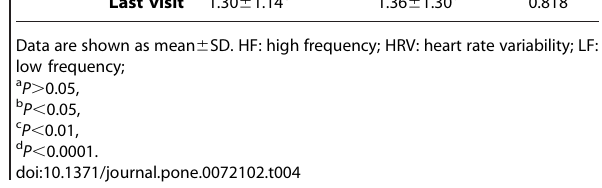
Figure 3. Changes in RHR from baseline to the end of treatment in the bisoprolol and atenolol groups.